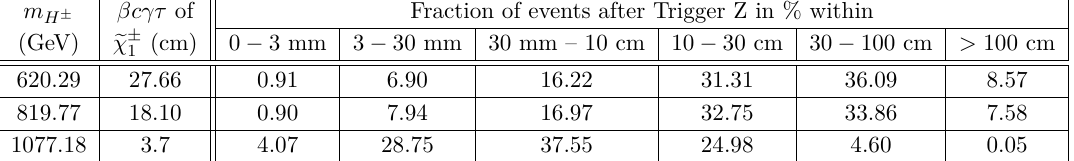
Table 31. The fractional number of events which decay at different parts inside tracker for the 4 F production process with H ± → p > 25 GeV and | η | < 2 . 5 . The di-lepton invariant mass should be within 15 GeV T